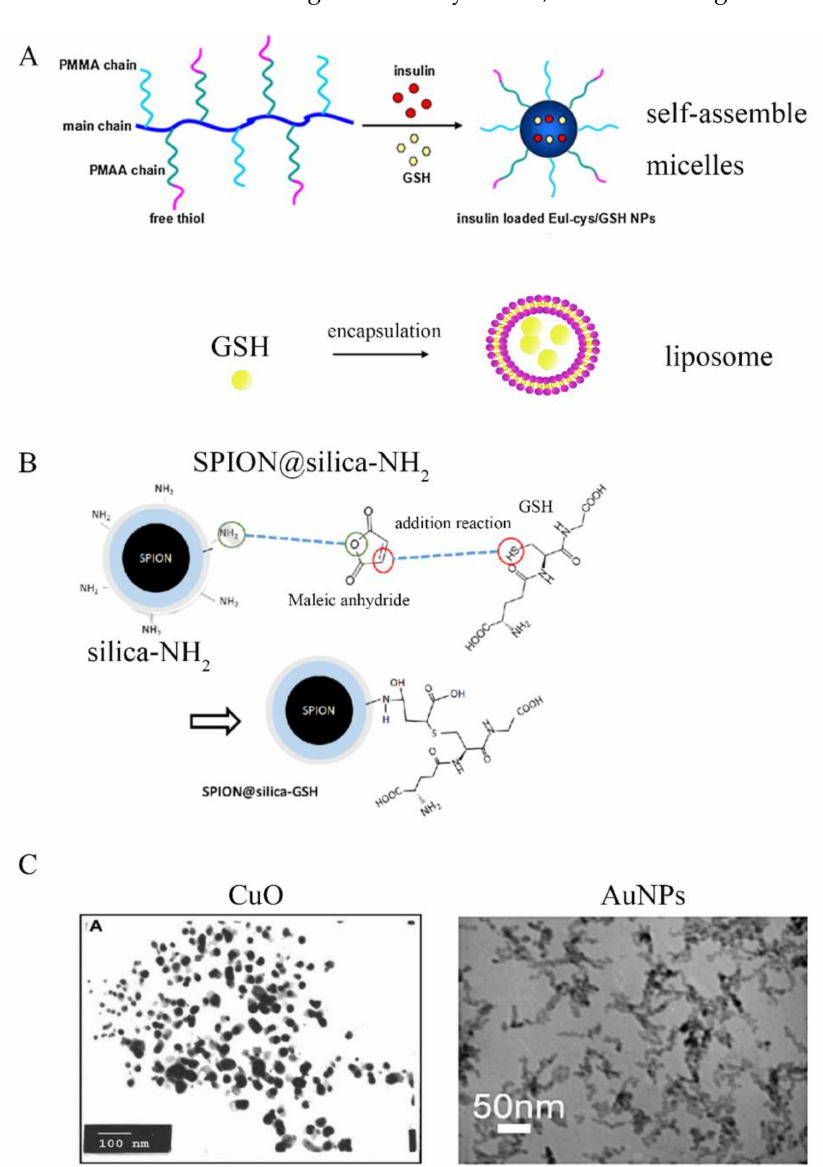
Figure 2. Nano-drugs for diabetes designment based on GSH. ( A ) GSH was encapsulated into Enteric eudragit L100-cysteine to prepare reduced glutathione nanoparticles (Eul-cys/GSH NPs) [30]; ( B ) GSH-bound magnetic nanoparticles (SPION@silica-NH 2 ). GSH was reacted with maleic anhy- dride to form SPION@silica-GSH nanoparticles [31]; ( C ) transmission electron microscope images